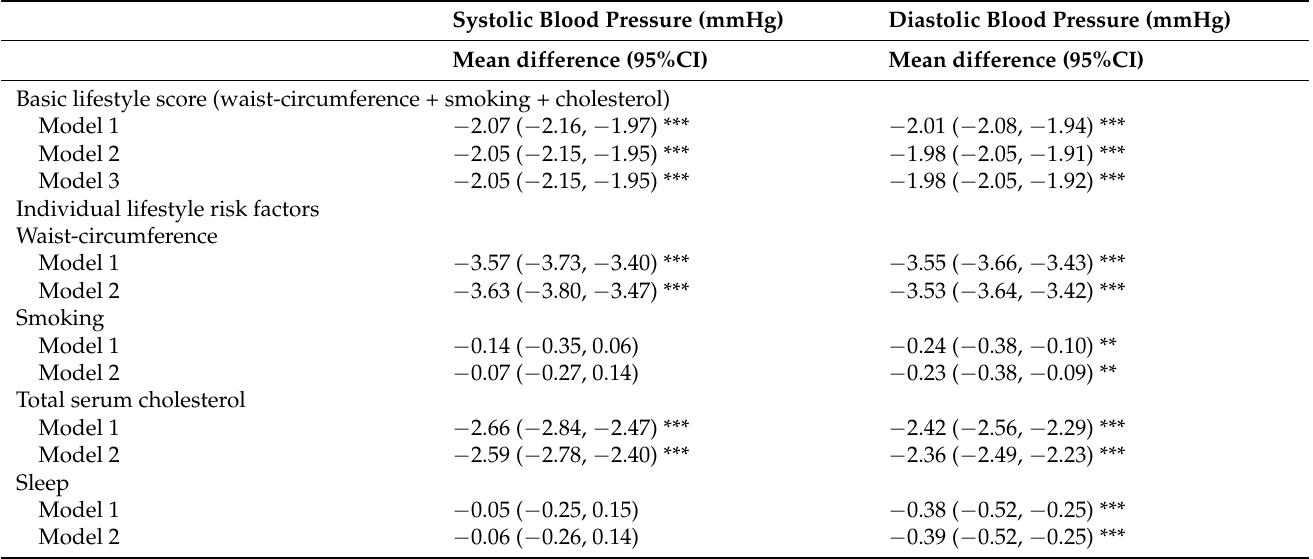
Table 3. Estimated mean difference in BP associated with a 1-point higher basic and lifestyle